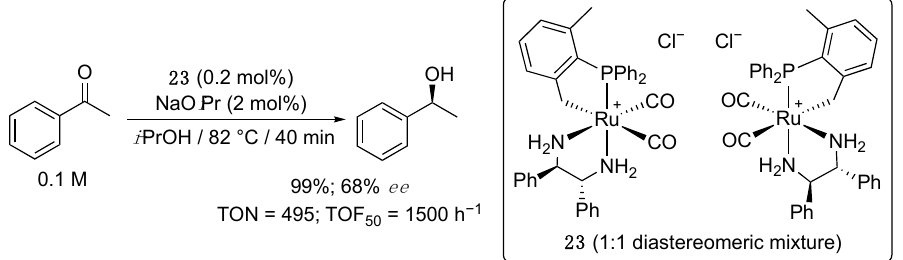
Scheme 14. ATH of acetophenone catalyzed by the 1:1 diastereomeric mixture of the CP -cyclomet- alated dicarbonyl complex 23